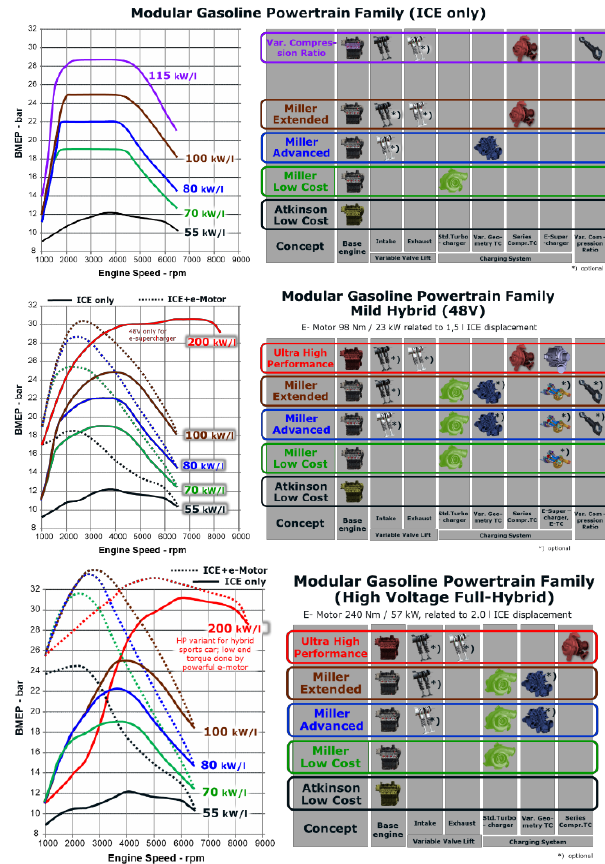
Fig. 12. Modular Gasoline engine concept with different electrification levels